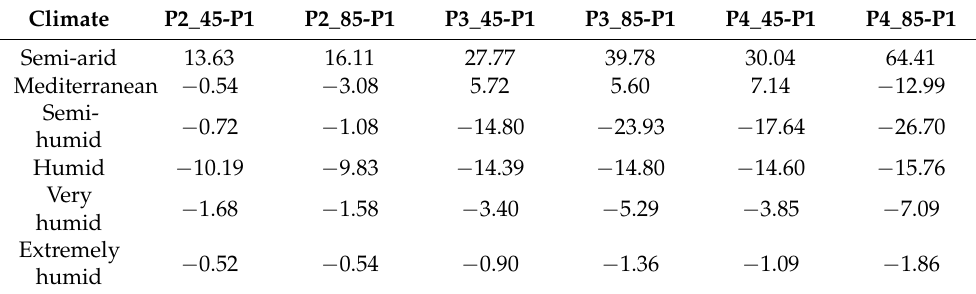
Table 6. Differences (%) between each scenario and the baseline climate